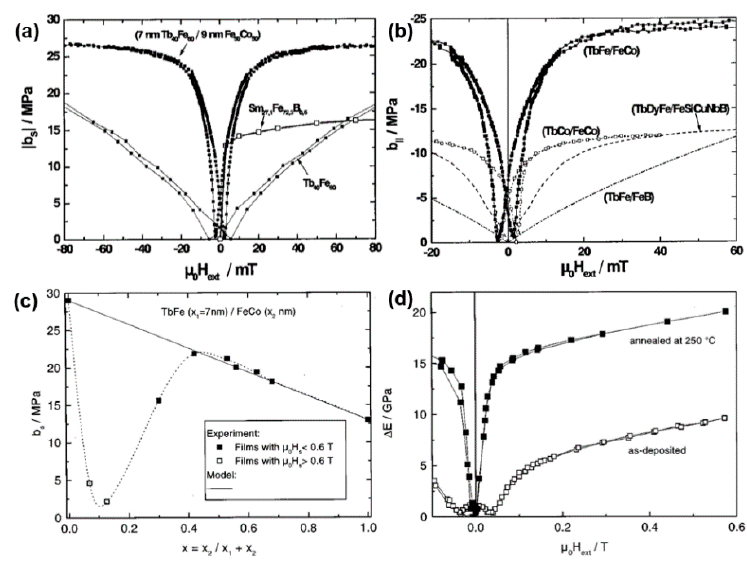
Figure 17. ( a ) Comparison of the magnetoelastic coupling coefficient of 250 °C annealed (7 nmTb 40 Fe 60 /9 nmFe 50 Co 50 ) × 70 multilayer with an optimized Tb 40 Fe 60 and a SmFeB film. ( b ) Comparison of the magnetoelastic coupling coefficients of (Tb 40 Fe 60 /Fe 50 Co 50 ), (Tb 18 Co 82 /Fe 75 Co 25 ), (TbDyFe/ FeSiCuNbB) and (Tb 33 Fe 67 /Fe 80 B 20 ) multilayer films. ( c ) Saturation magnetoelastic coupling coefficient of TbFe/FeCo multilayers as a function of the soft magnetic layer thickness. ( d ) ∆ E effect of as-deposited and at 250 °C annealed (7 nm TbFe/8 nm FeCo) multilayers. There figures are reproduced with the permission from [116,117]. Copyright [1999] and [2000], American Physical Society.